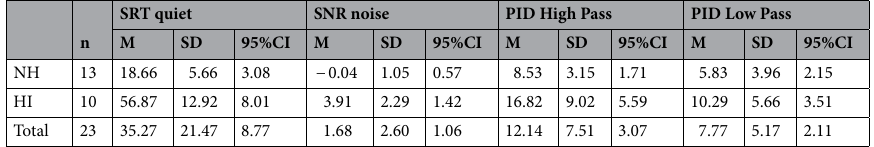
Table 1. Descriptive statistics for speech perception (speech reception threshold or SRT) and phase inversion discrimination (PID) for high-pass and low-pass filtered stimuli are shown for normal hearing (NH) and hearing-impaired (HI) subjects. Mean (M), standard deviation (SD) and 95% confidence intervals (95%CI) are